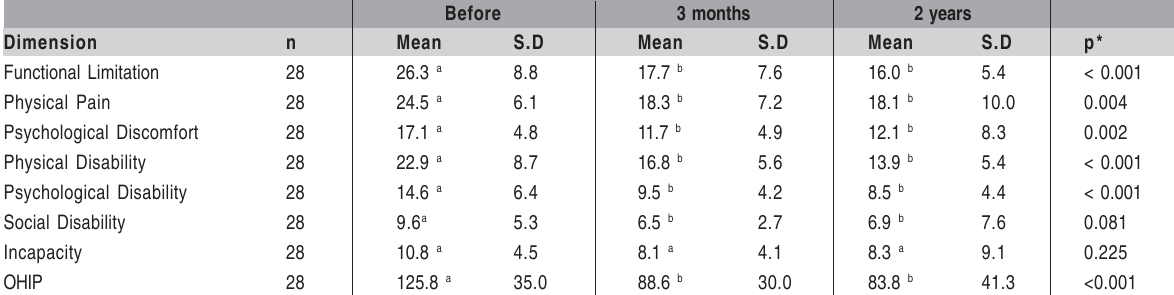
Table 1 : OHIP Values of the respective dimensions in relation to time: before, after 3 months and after 2 years of RPD use.